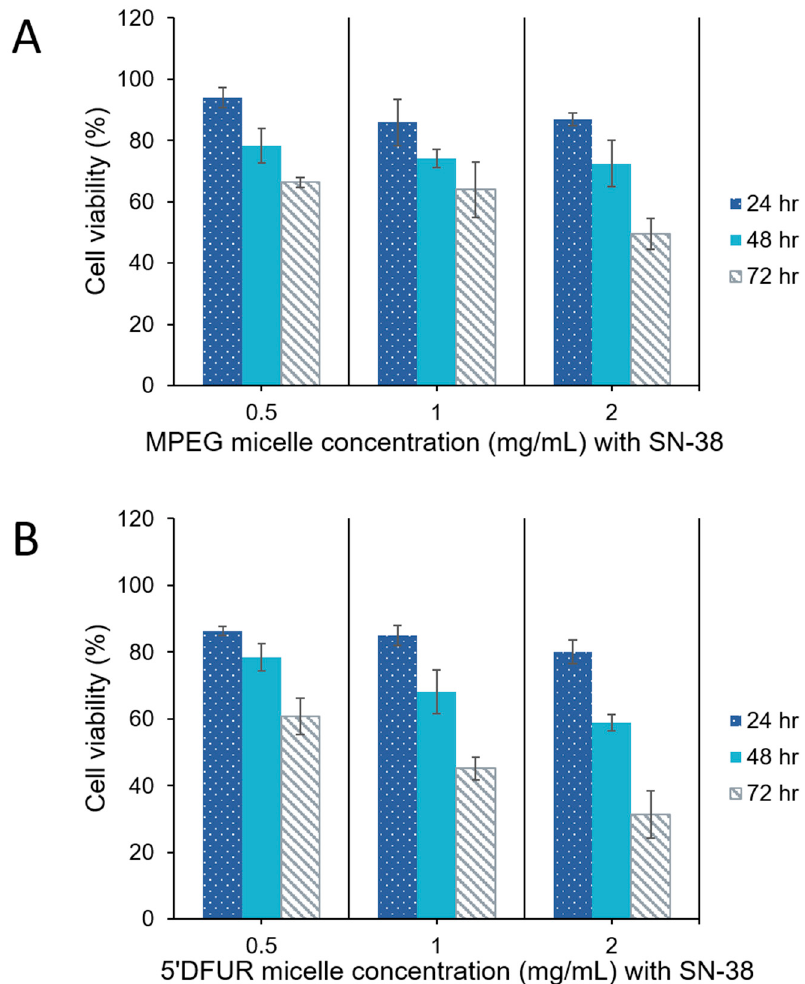
Figure 10. Cell viability of HT-29 cells after treatment with polymeric micelles encapsulating SN-38 for 24, 48, and 72 h. ( A ) MPEG 350 -PCL-MPEG polymeric micelles, ( B ) 5’-DFUR-PCL-MPEG polymeric micelles (mean ± SD, n = 3).